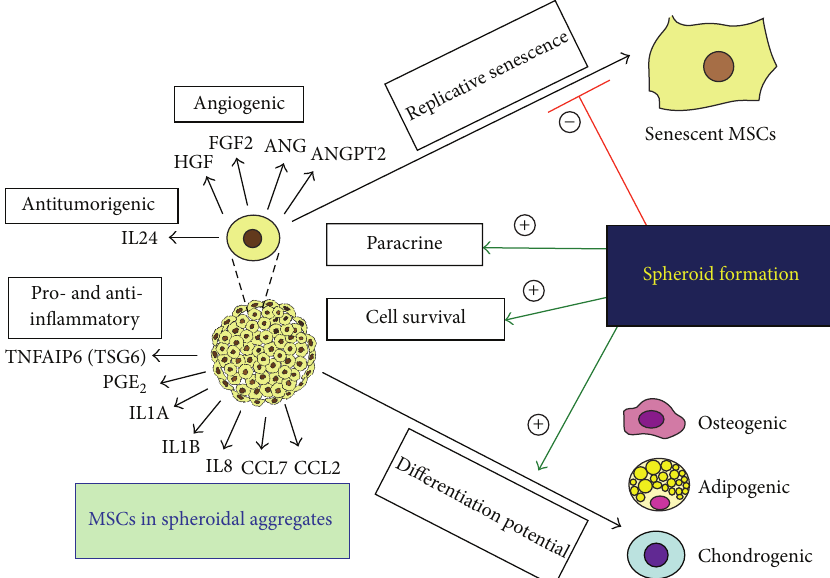
Figure 1: Clinical significance of MSC spheroids. Formation of spheroidal aggregates (1) enhances paracrine secretion of angiogenic, antitumorigenic, and pro- and anti-inflammatory factors, (2) improves cell survival, (3) increases differentiation potentials, and (4) delays replicative senescence of MSCs (ANG: angiogenin; ANGPT2: angiopoietin 2; CCL2: chemokine (C-C motif) ligand 2; CCL7: chemokine (C-C motif) ligand 7; FGF2: fibroblast growth factor 2; HGF: hepatocyte growth factor; IL1A: interleukin 1 𝛼 ; IL1B: interleukin 1 𝛽 ; IL8: interleukin 8; IL24: interleukin 24; PGE 2 : prostaglandin E 2 ; TNFAIP6 (TSG6): tumor necrosis factor 𝛼 -induced protein 6 (tumor necrosis factor 𝛼 stimulated gene/protein 6); VEGFA: vascular endothelial growth